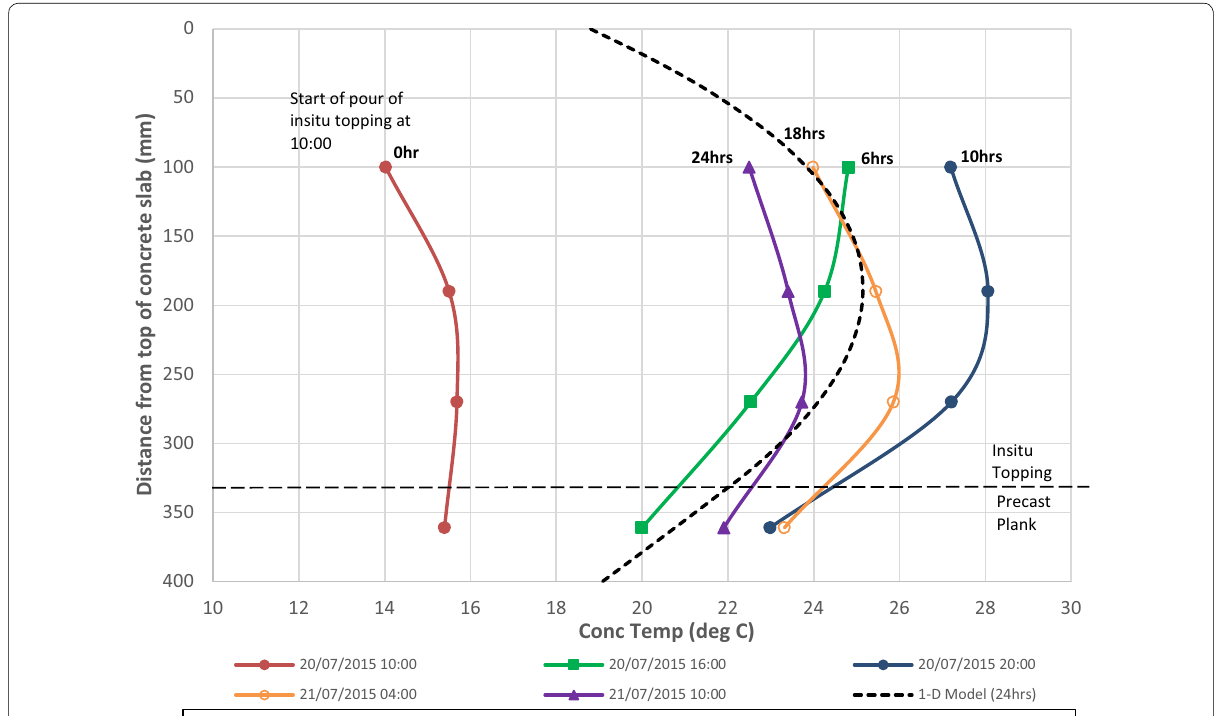
Fig. 10 Temperature profile in concrete slab for first 24